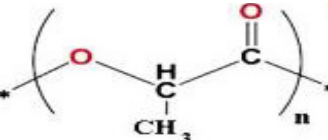
Figure 5:A) Chemical structure of PLA.